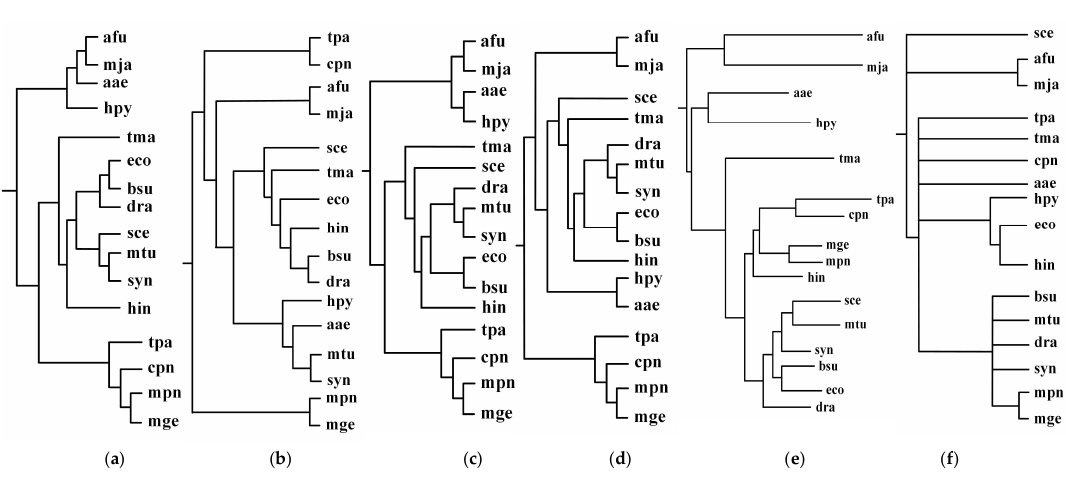
Figure 3. Similarities between our trees and the NCBI taxonomy for the 16 organisms.